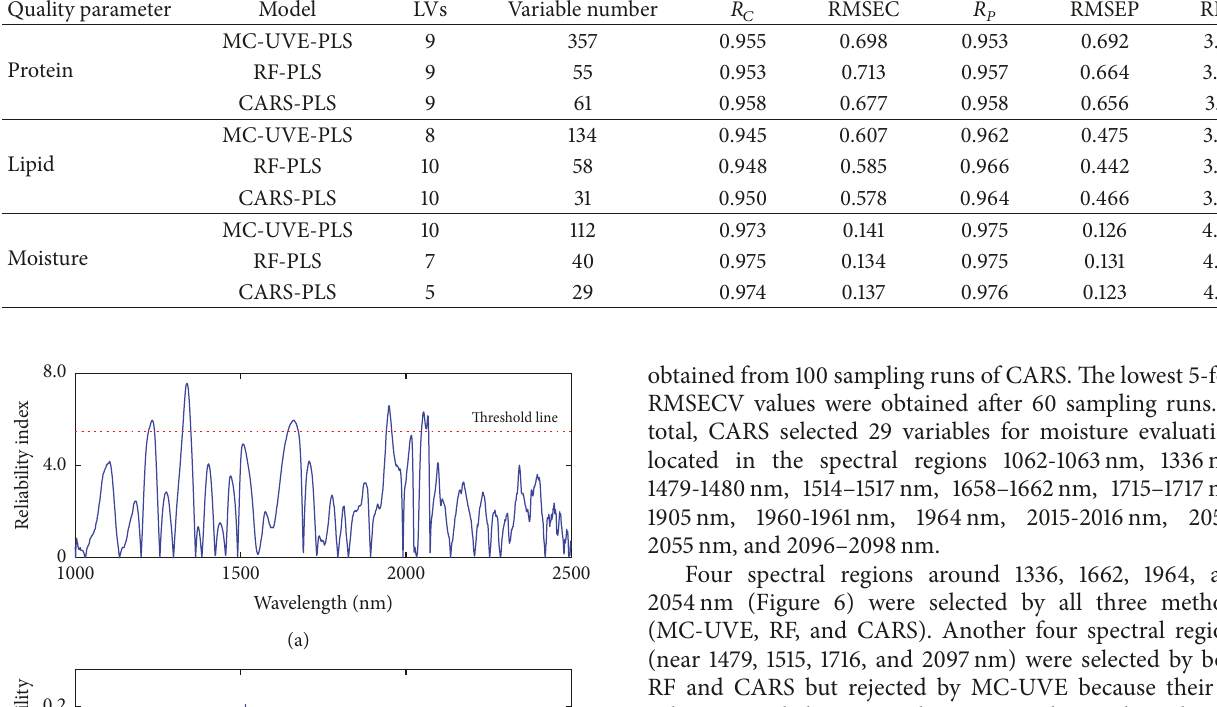
Table 3: Calibration and prediction results of protein, lipid, and moisture contents in Fuzhu obtained by different PLS models. Quality parameter